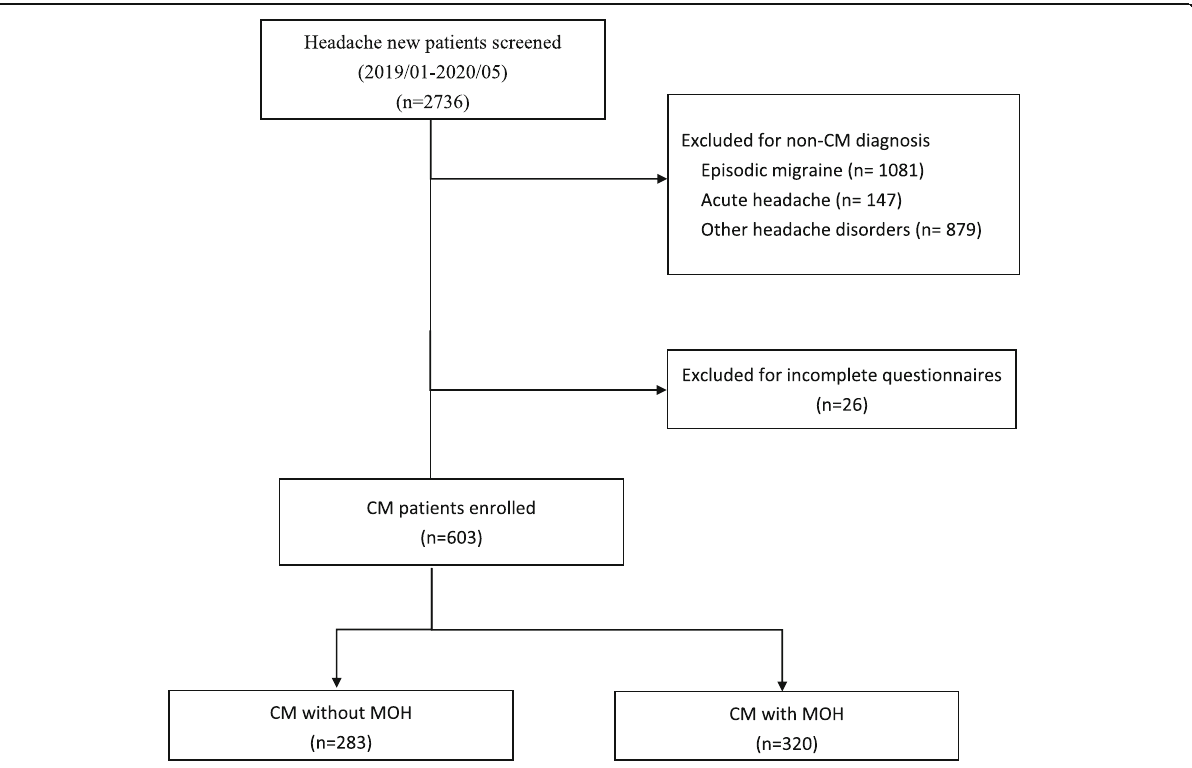
Fig. 1 Patient recruitment in the present study